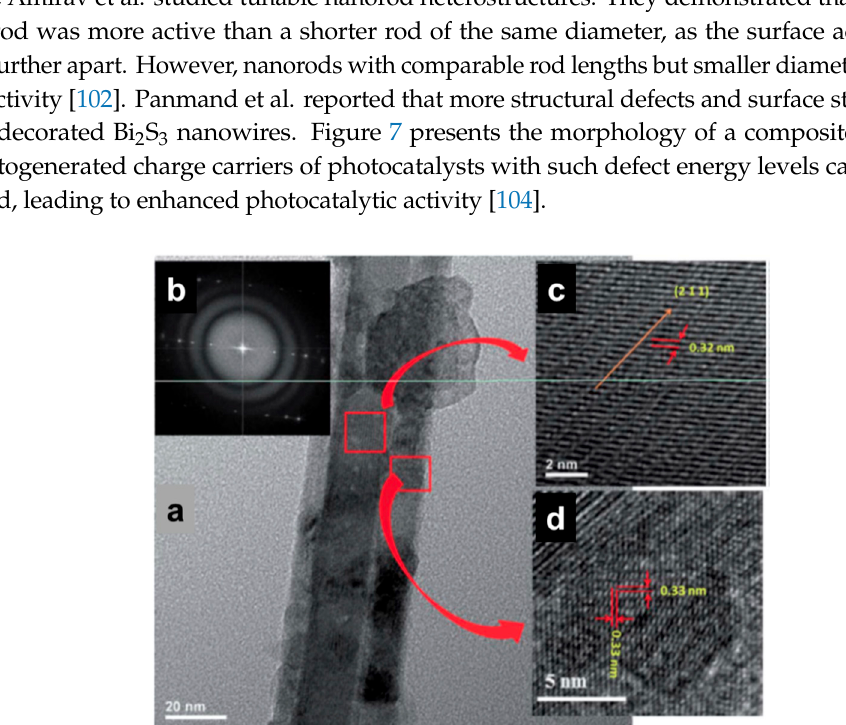
Table 10. Photocatalytic activity of photocatalysts using di ff erent sacrificial agents.